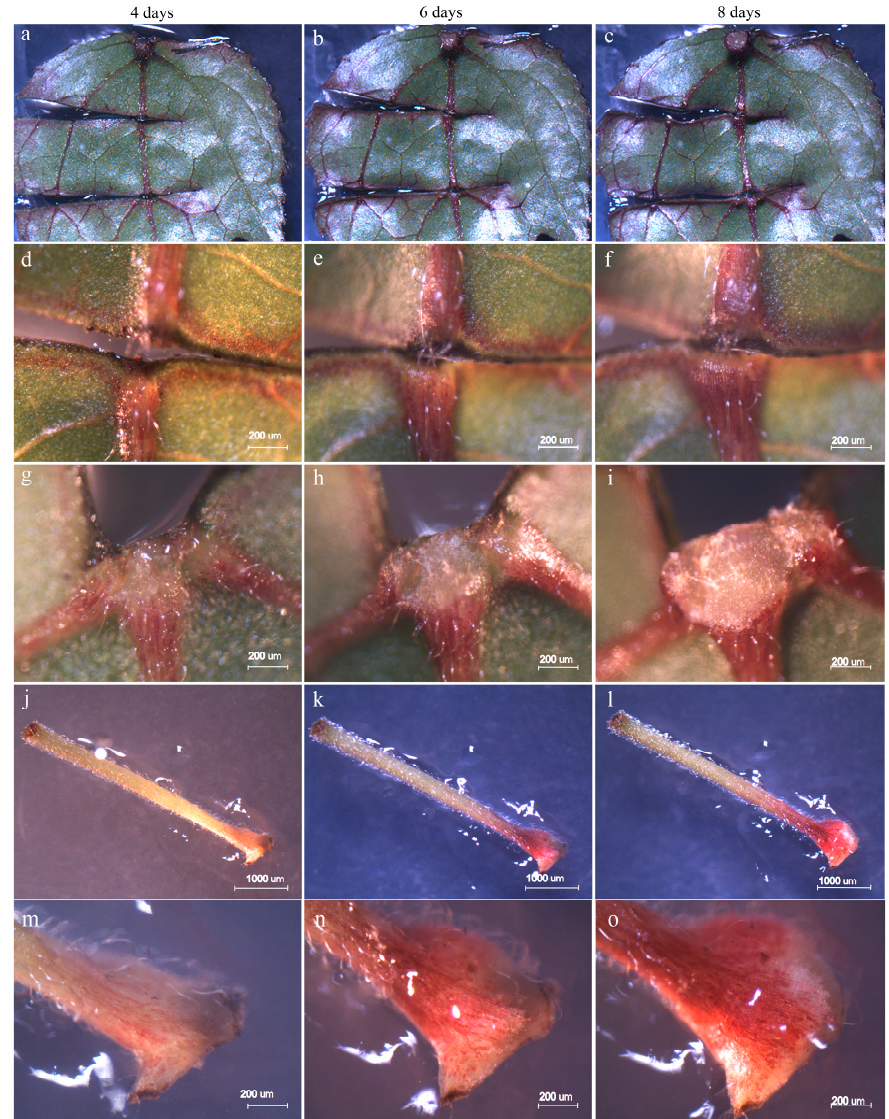
Figure 1. Morphology of leaves and petioles cultured in regeneration medium after 4, 6, and 8 days. ( a – c ) morphology of leaves cultured for 4, 6, and 8 days, respectively; ( d - f ) morphology of the second wound in the leaf main vein at 4, 6, and 8 days respectively; ( g - I ) morphology of the first wound in the leaf main vein at 4, 6, and 8 days, respectively; ( j - l ) morphology of the petiole cultured for 4, 6, and 8 days, respectively; ( m - o ) morphology of one end of the petiole cultured for 4, 6, and 8 days, respectively.